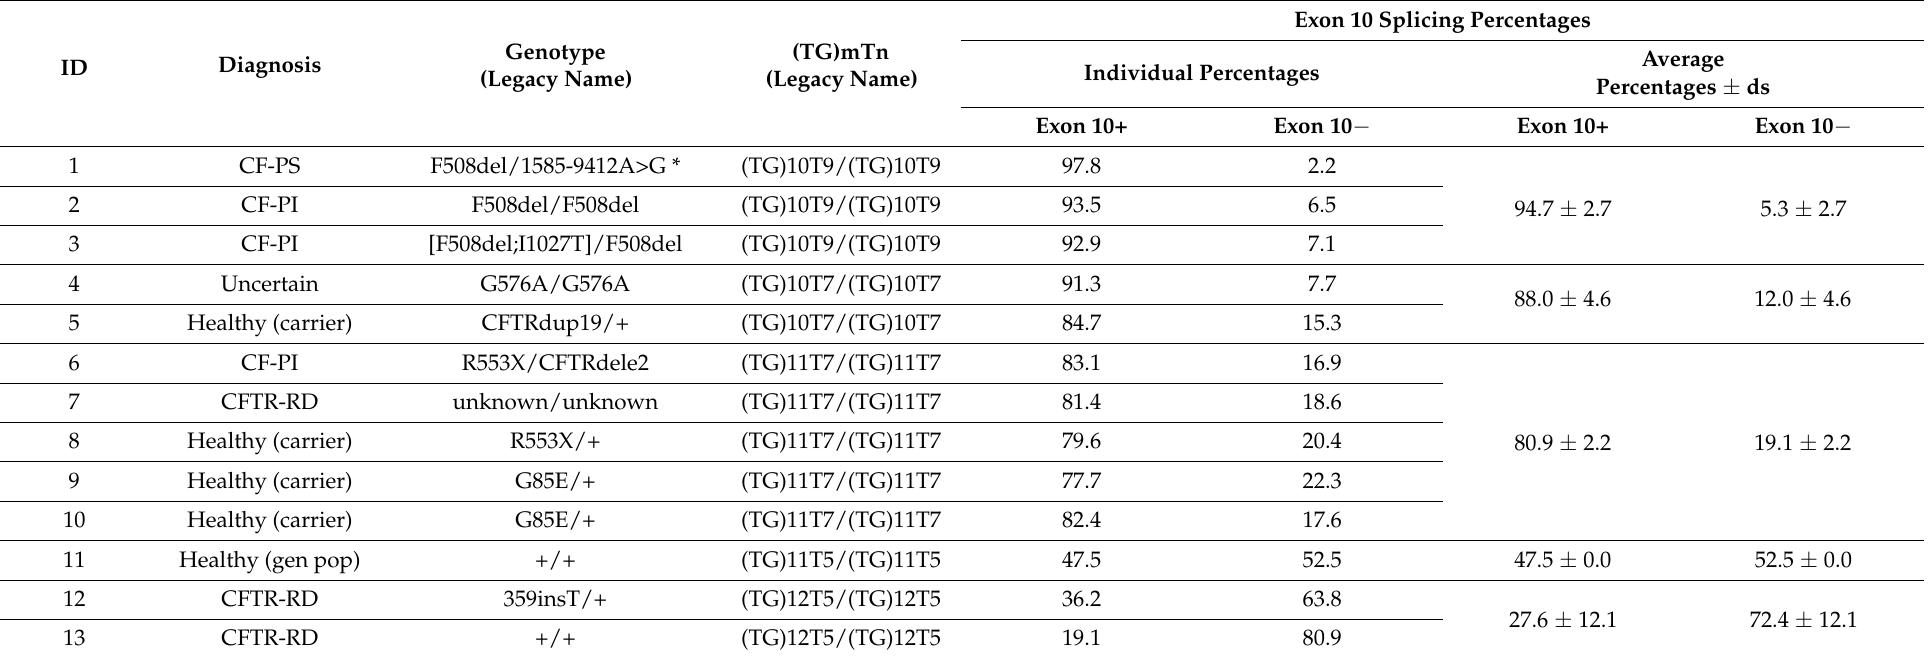
Table 1. Genotypes and splicing